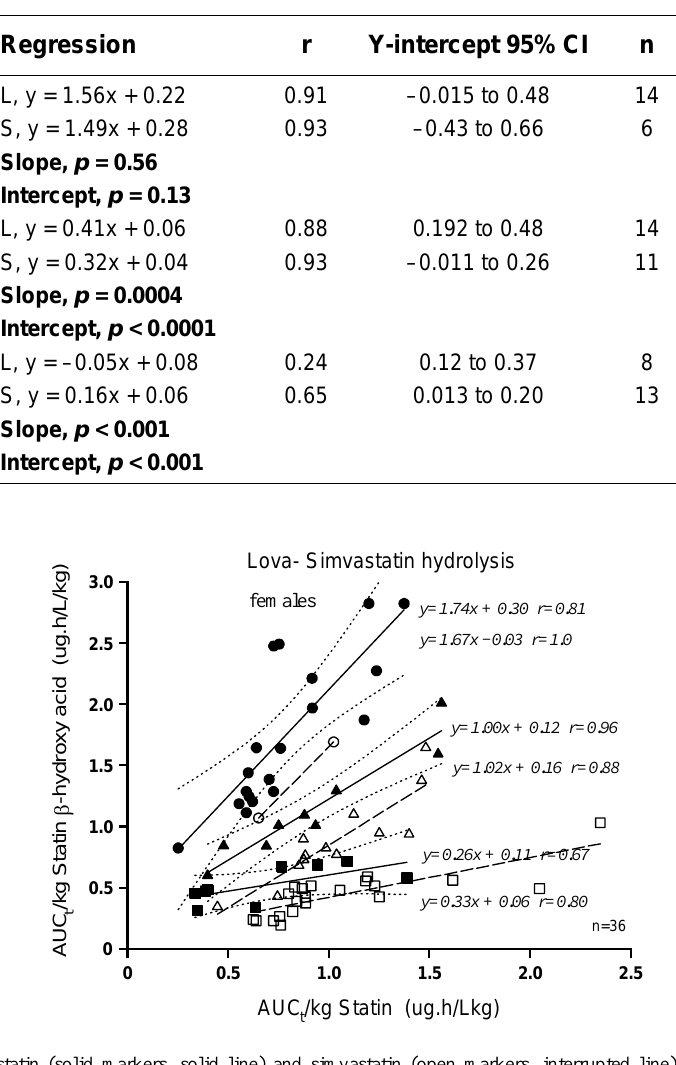
FIGURE 4. AUC t /kg of lovastatin (solid markers, solid line) and simvastatin (open markers, interrupted line) plotted vs. the corresponding AUC t /kg of the metabolite after an oral dose of 80 mg of the statin in female volunteers. Both statins show three groups of hydrolysis activities in both groups of female volunteers (parallel design). (Dotted lines are 95%